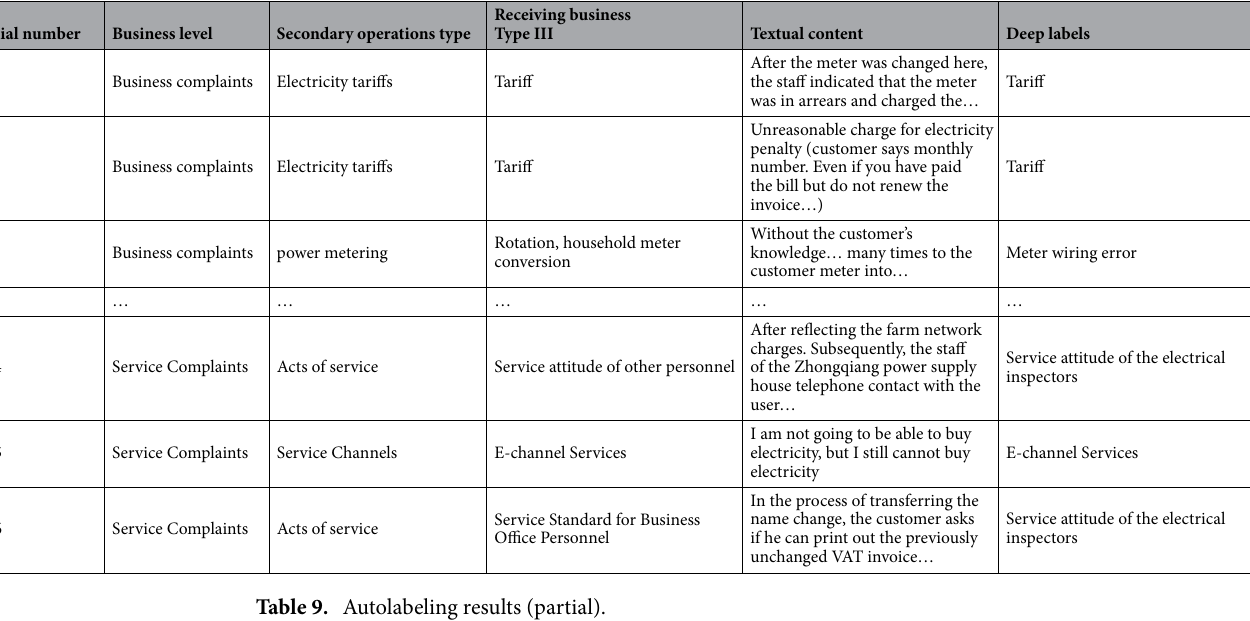
Table 9. Autolabeling results